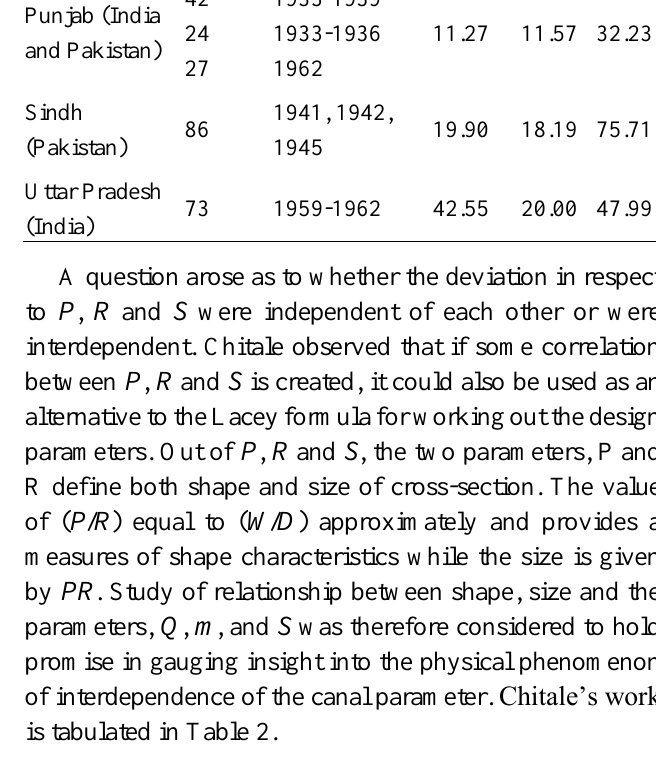
Percentages of Deviations with Lacey Formulae No. Region